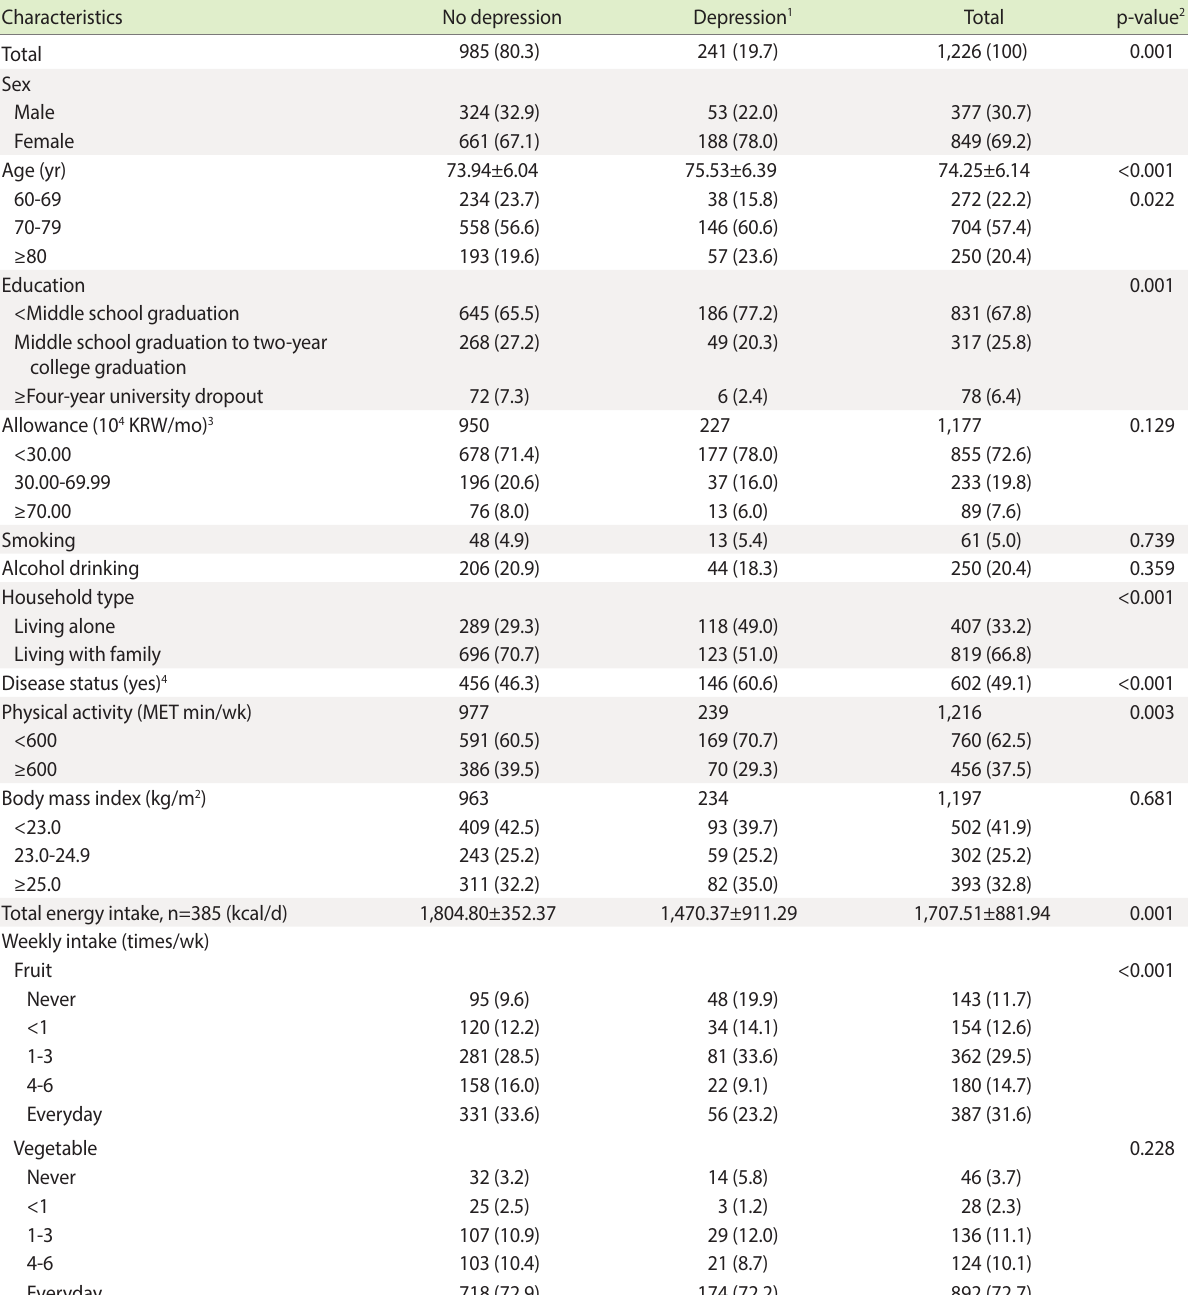
Table 1. General characteristics of study participants